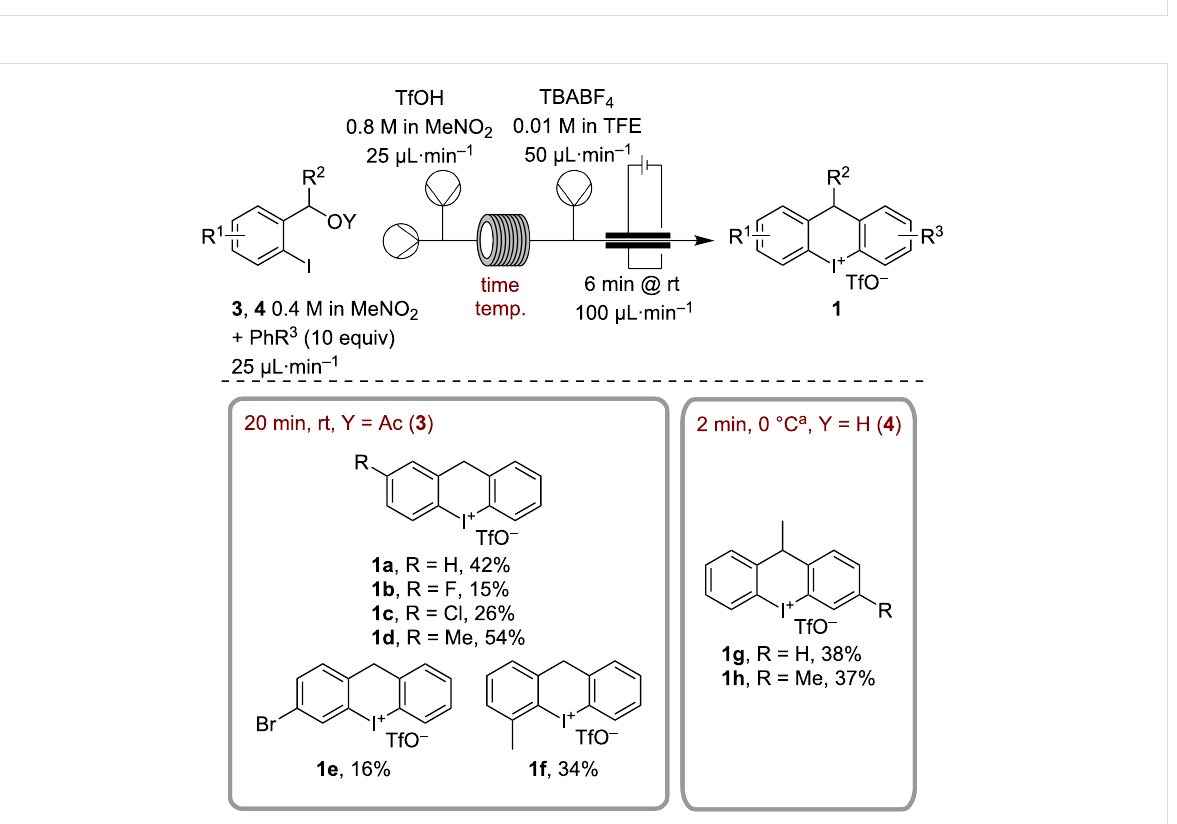
Figure 1: Substrate scope using the optimized conditions of Table 3. Yield is based on collecting for 3 h 20 min (2.00 mmol) after two reactor volumes had passed at the respective conditions. a Solutions of benzyl alocohol and TfOH were precooled in flow before mixing (see Supporting Information File